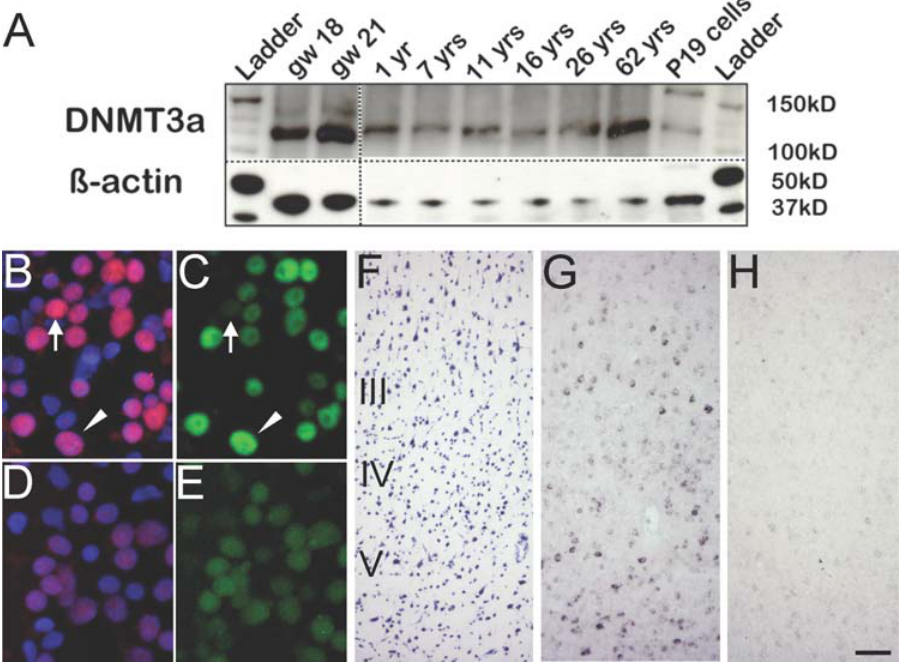
Figure 4. Developmental and cellular expression pattern of DNMT3a in the cerebral cortex. ( A ) Representative immunoblotting of temporal cortex homogenates with anti-DNMT3a antibody (top) and b -actin as loading control (bottom). Left, fetal samples (gw=gestational week); right, child and adult brains (yrs=years) and, as positive control, murine embryonic carcinoma, ‘‘P19’’ cells. Notice expression of DNMT3a—indicated by a , 120 kDa band—across all ages. ( B, C ) Digitized images of temporal cortex nuclei from 1 year old infant, processed for DNMT3a (red) and NeuN (green) immunoreactivity and counterstained with DAPI. Notice numerous neuronal nuclei expressing both markers, including representative example marked by arrowhead. Occasional non-neuronal DNMT3a + nucleus is marked by arrow. ( D,E ) show weak background staining and formalin fixation- related autofluorescence in negative controls processed without primary antibodies. ( F–H ) Images from layers III, IV and V of parallel sections from adult temporal cortex, stained for Nissl (F) or hybridized with digoxigenin-labeled DNMT3a antisense (G) or sense riboprobe (H). Notice in (G) robust expression of DNMT3a mRNA in a subset of layer III and V neurons. Images in B–E taken at with 20 6 objective. Bar (F–H) in H=100 m m.